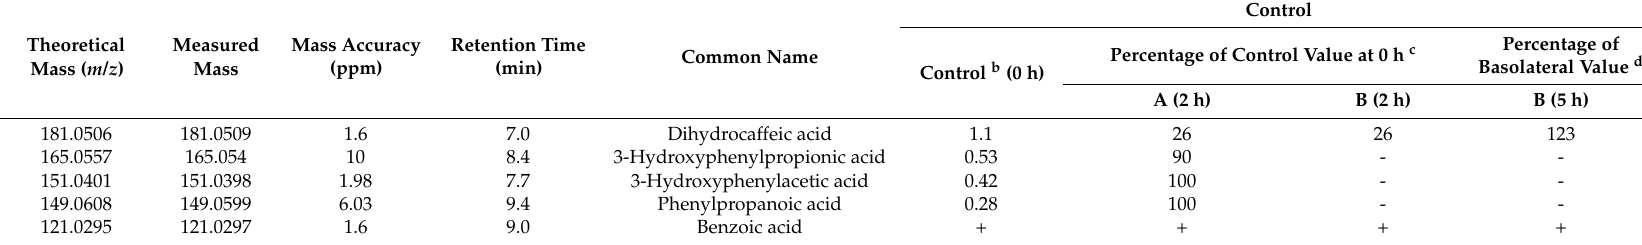
Table 3. Polyphenols and their metabolites in control digesta ( t = 0 h) and amount expressed as a percentage of initial control values in the apical ( t = 2 h) and basolateral ( t = 2 h) chambers in the Caco-2 cell transport bioassay and basolateral ( t = 5 h) chamber in the HepG2 cell metabolism bioassay a .